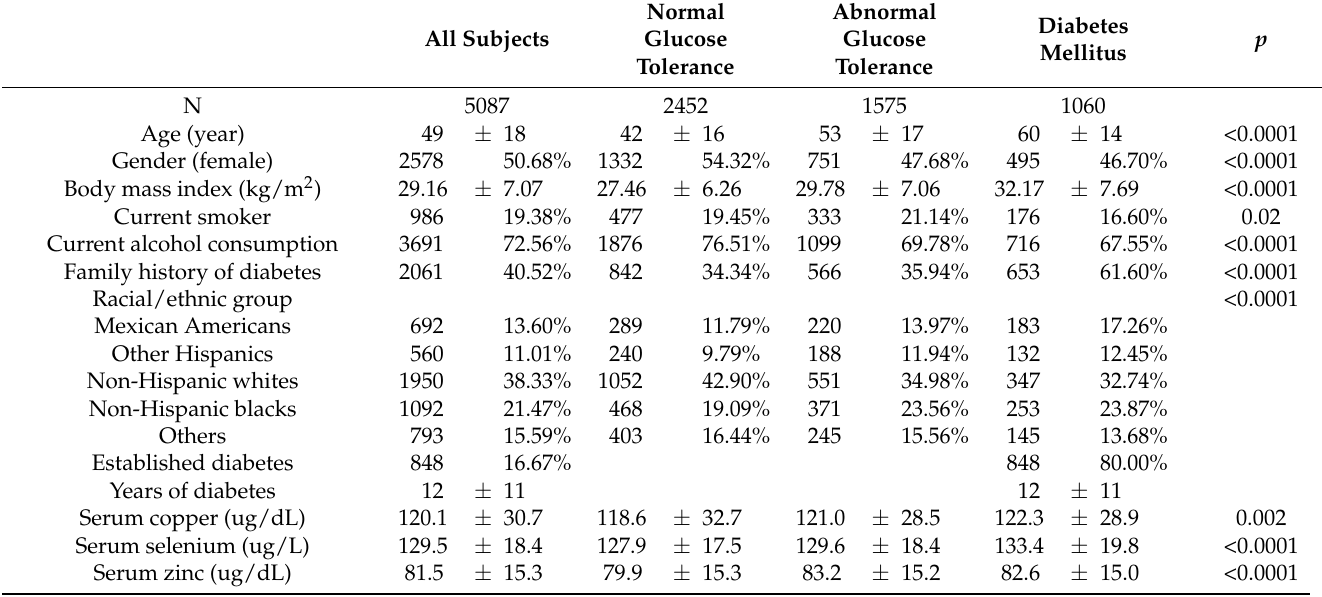
Figure 1. Sampling scheme. Table 1. Clinical characteristics of study